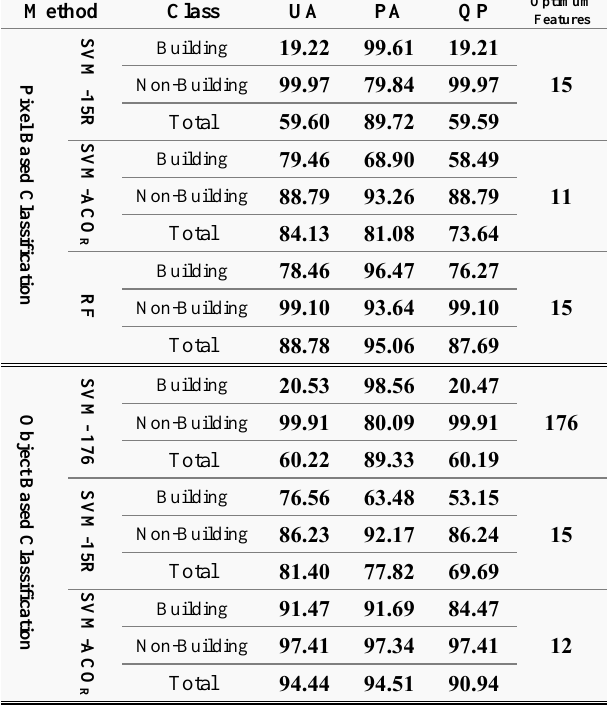
Table 3. The accuracy assessment results obtained from different